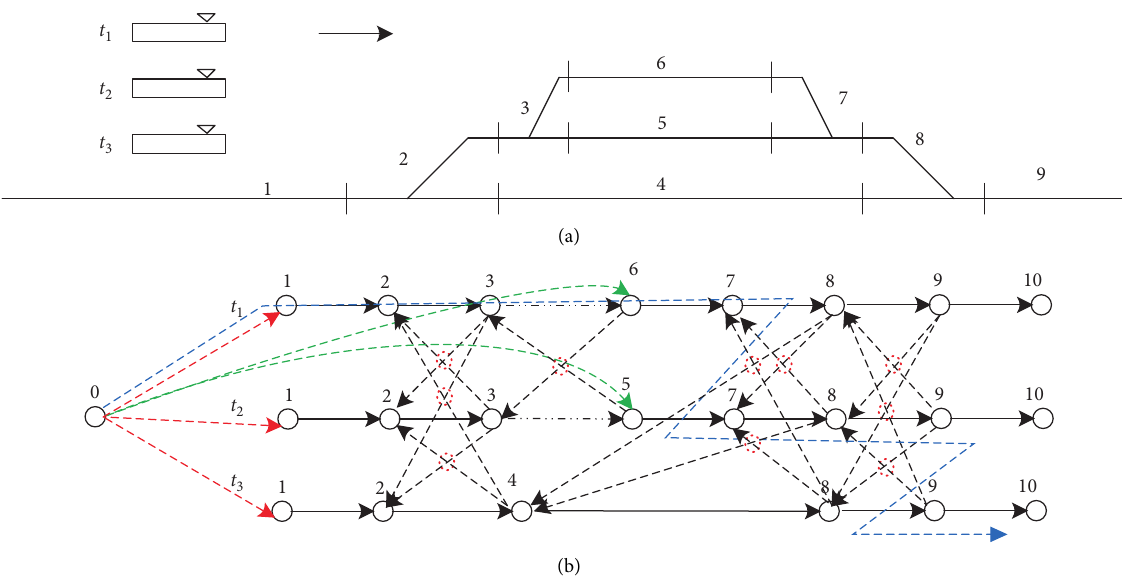
Figure 2: Alternative graph with two trains in one railway station.